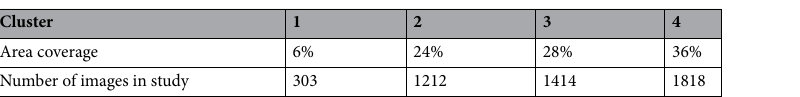
Table 2. Area coverage and number of images used from the division of the study area based on clustering of bathymetric parameters.